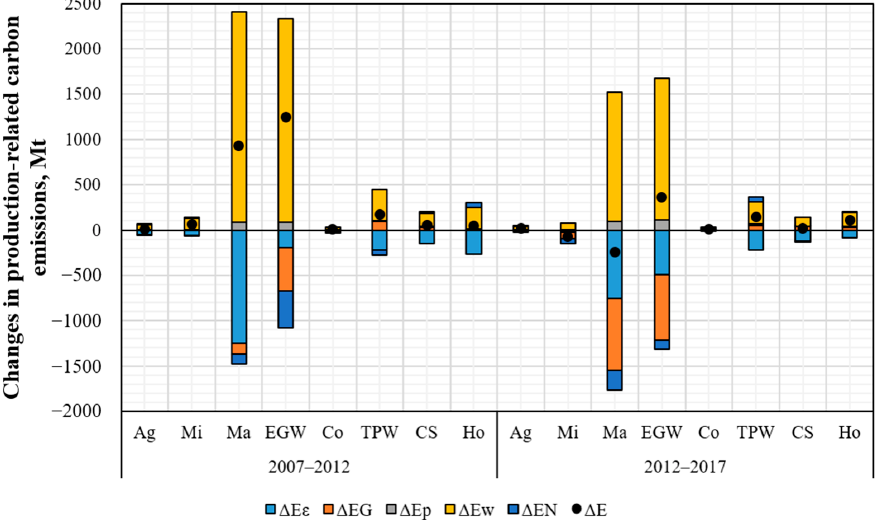
Figure 2. SDA results of changes in sectoral production-related carbon emissions (Mt).